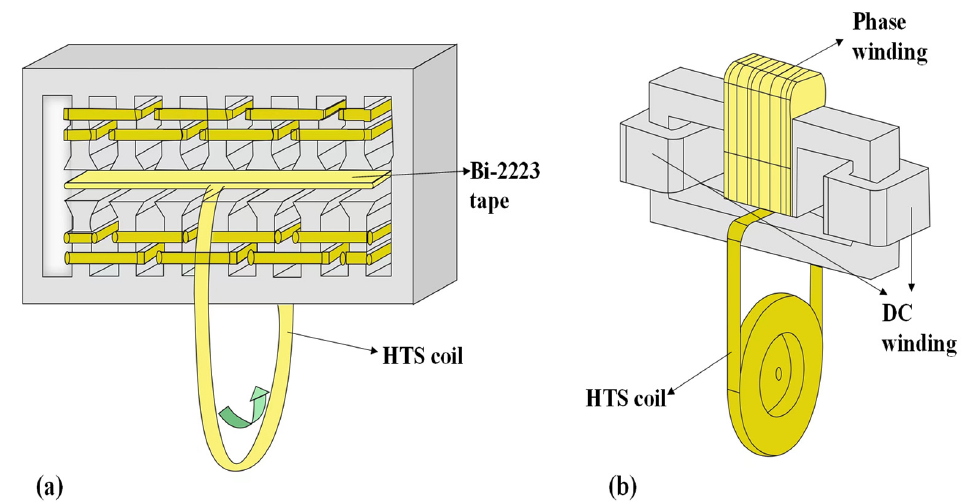
Figure 16. ( a ) Structure diagram of a pulse-type HTS flux pump. Adapted from [125]. ( b ) Experimental configuration of the linear HTS flux pump. Adapted from [130].